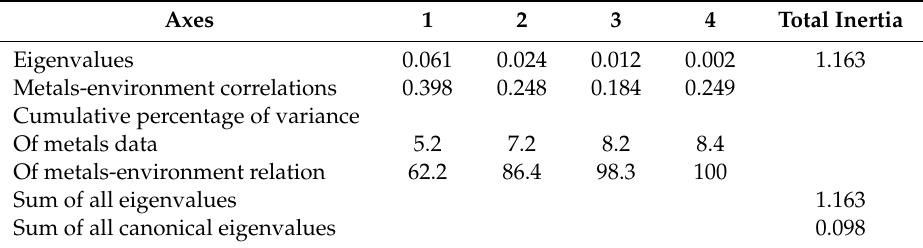
Table 5. Axis values of global canonical correlation